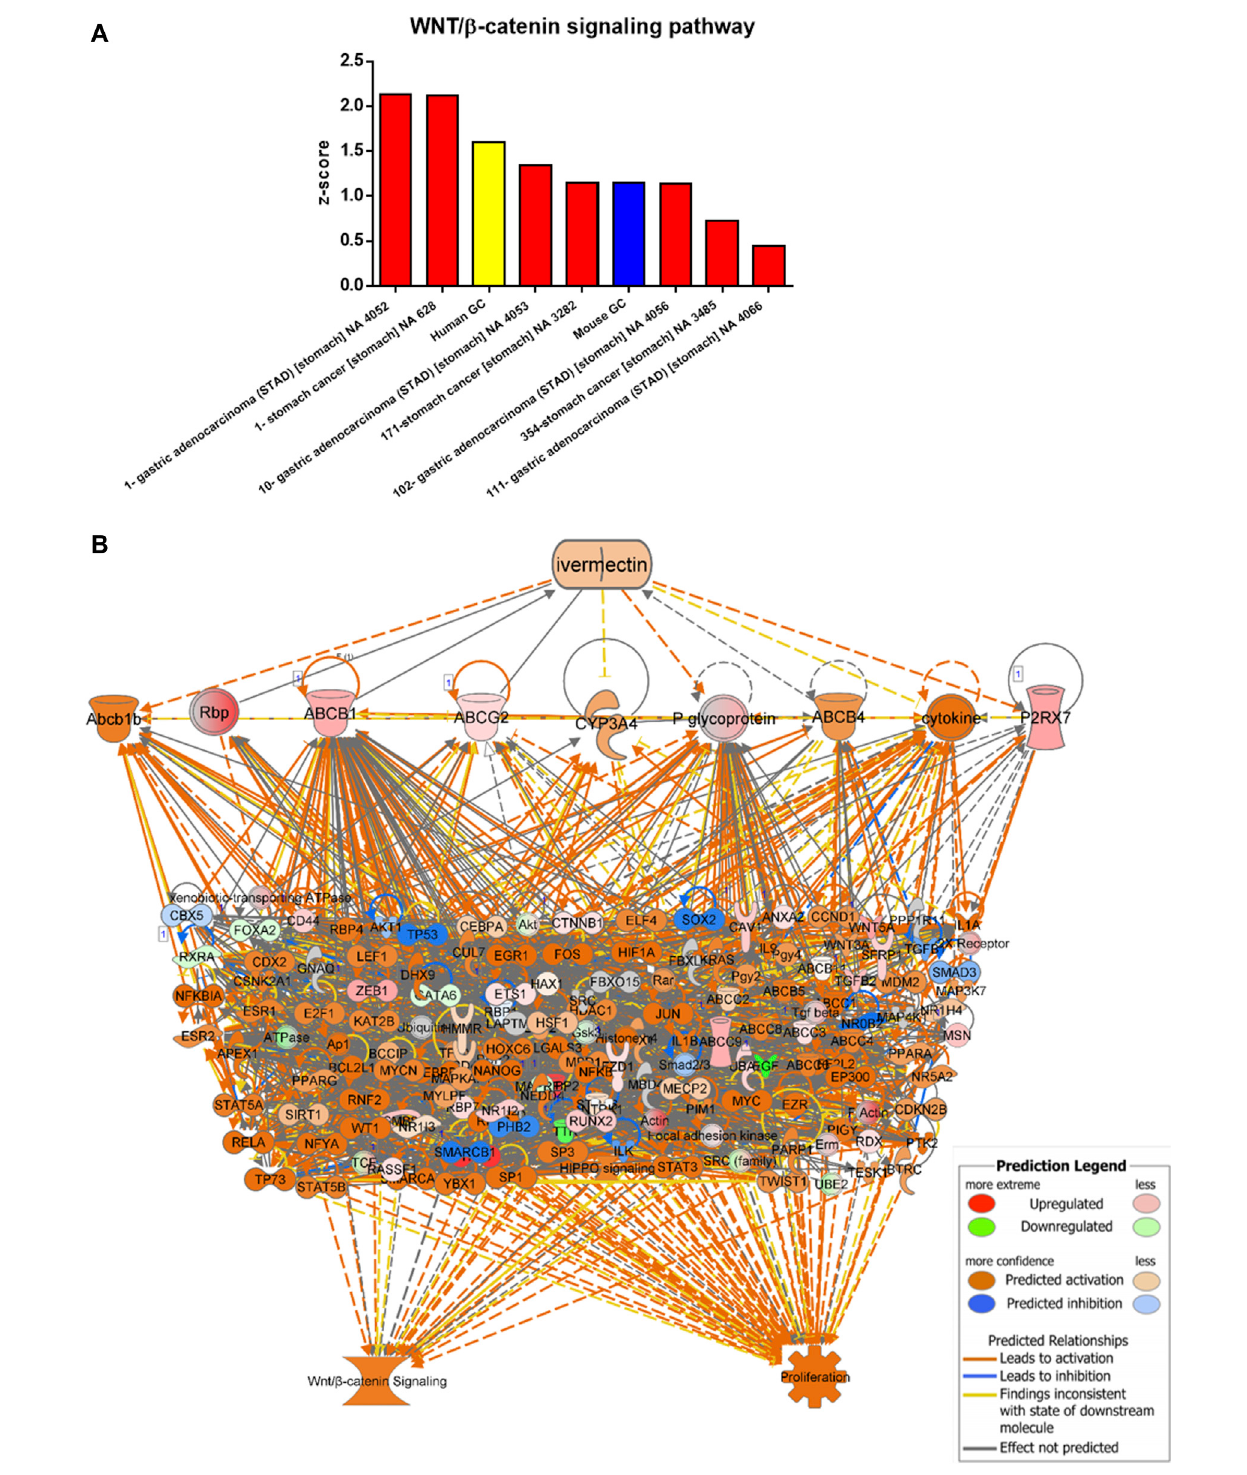
FIGURE3| Data/pathwayminingofWNT/ β -cateninsignalingpathway. (A) ActivationofWNT/ β -cateninsignalingpathwayineightdatasetsofhumanGC(including oneusedinthepresentstudyasindicatedinyellow)andonedatasetofmouseGC(inblue). (B) Hierarchicalnetworkrepresentationshowingivermectinanddrugtargets with downstream signaling pathways of WNT/ β -catenin and proliferation. The schema was created in IPA using the grow-tool and the Ingenuity Knowledge Base. The molecular entities (genes and proteins) as well as molecular functions and interactive networks were connected based on interrelationships identi fi ed by the Ingenuity Knowledge Base. Expression levels from mouse GC vs. WT. p < 0.05. See also Table 3 In silico testing shows ivermectin inhibits WNT/ β -catenin signaling.